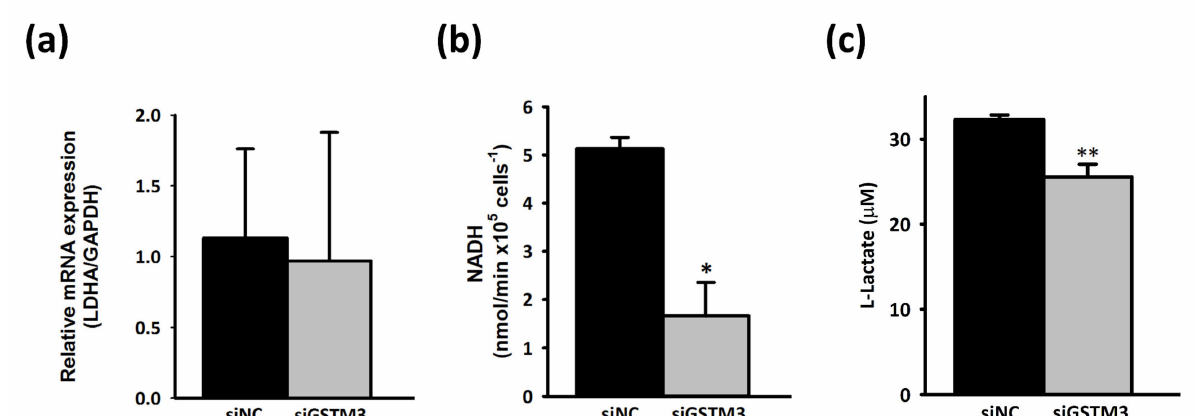
Figure 6. Knockdown of siGSTM3 affects LDH activity in T98G glioblastoma cells. T98G cells treated with siRNA knockdown were depleted 72 h after transfection. ( a ) The lactate dehydrogenase A (LDHA) mRNA expression level was examined using reverse-transcription polymerase chain reaction. GAPDH was used as an internal control. Values are expressed as the mean ± SD ( n = 3). * p < 0.05 relative to siNC. ( b ) The LDH activities of siNC and siGSTM3 T98G cells were measured using a Pierce LDH Cytotoxicity Assay Kit (Thermo Scientific). Endogenous proteins were extracted from each cell population. Each measurement was obtained for 1 × 10 5 cells. Values are expressed as the mean ± SD ( n = 3). * p < 0.05 relative to siNC. ( c ) The L-lactate content of siNC and siGSTM3 T98G cells was measured using an L-Lactate Assay Kit. Each measurement was obtained for 100 µ g of lysate. Values are expressed as the mean ± SD ( n = 3). ** p < 0.01 relative to siNC.